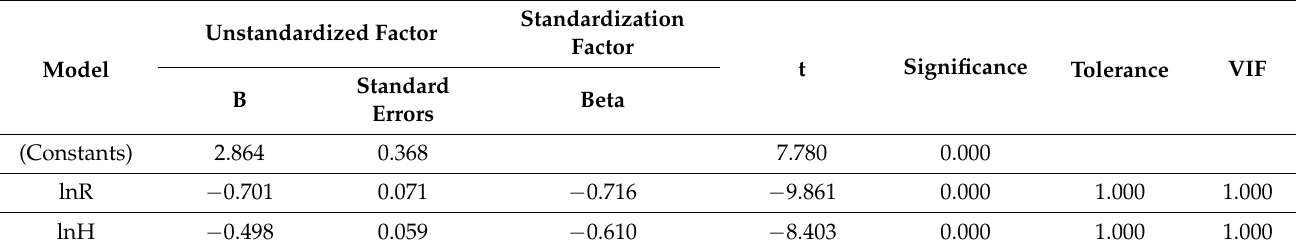
Table 6. Peak vibration speed regression